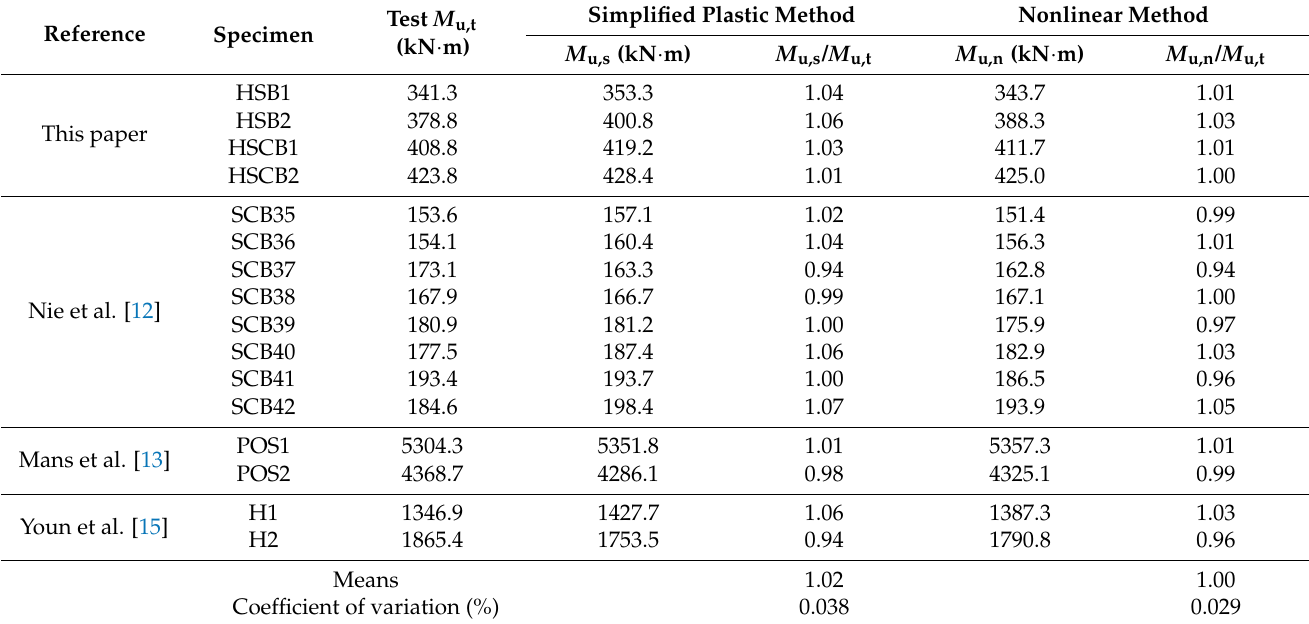
Table 4. Comparison between experimental and theoretical results of ultimate bending